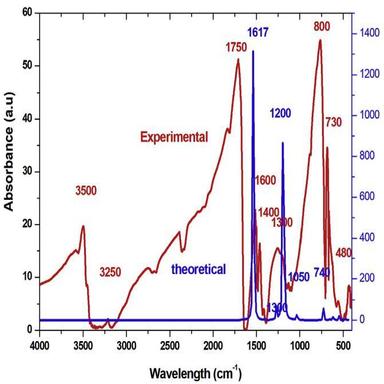
Fourier transform infrared spectra of tetrakis(thiourea)cobalt chloride single crystal.